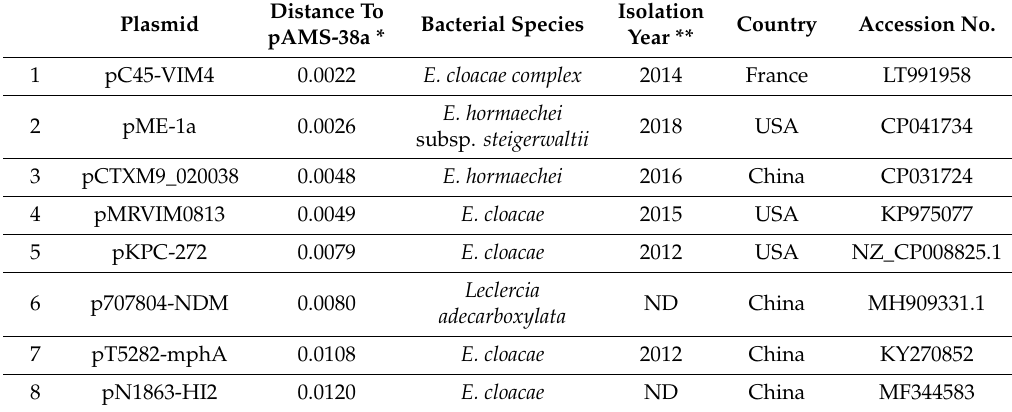
Table 2. Features of mcr-9 / IncHI2 plasmids similar to